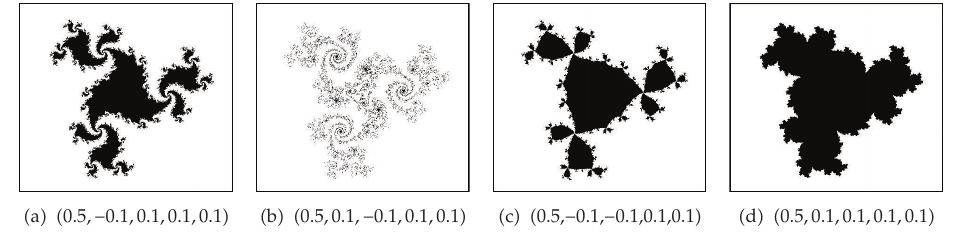
Figure 22: The generalized J sets perturbed by the composing noise when α (cid:6) 3 and c (cid:6) − 0 . 5 − 0 . 5 i